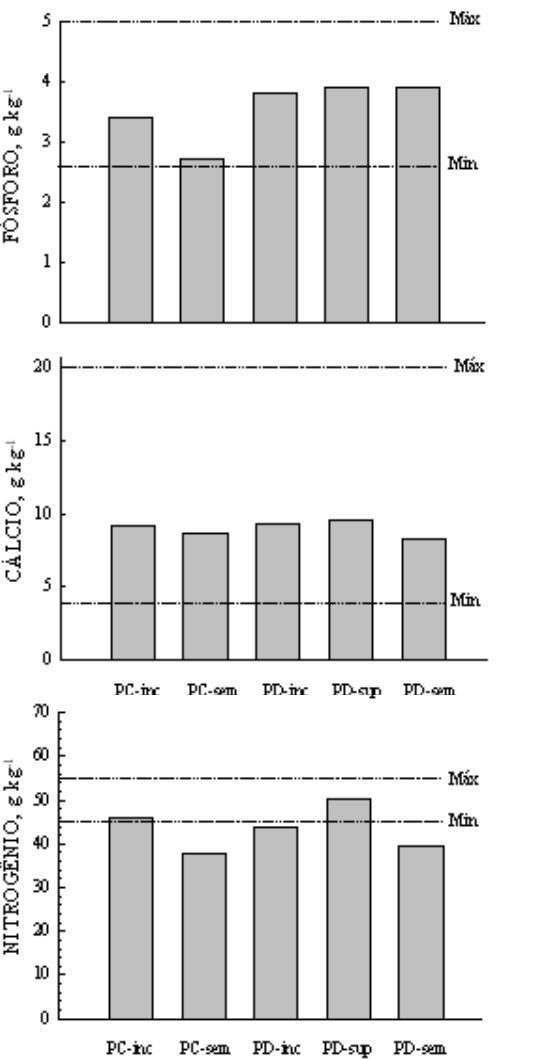
Figura 1. Teores de nutrientes no tecido da soja cultivada em plantio direto e preparo convencional em Latossolo Bruno Alumínico em Guarapuava – PR. PC inc = preparo convencional com calcário; PC sem = preparo convencional sem calcário; PD inc = plantio direto com calcário incorporado; PD sup = plantio direto com calcário superficial; PD sem = plantio direto sem calcário. Máx e Min são os níveis máximos e mínimos adequados para cada elemento no tecido da soja.